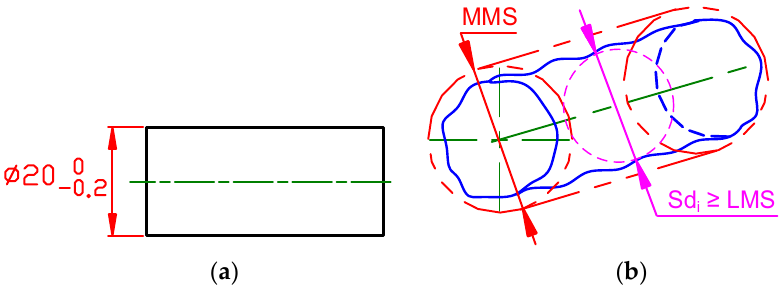
Figure 1. ( a ) The size tolerance applied to a pin (ASME Y14.5); ( b ) meaning.